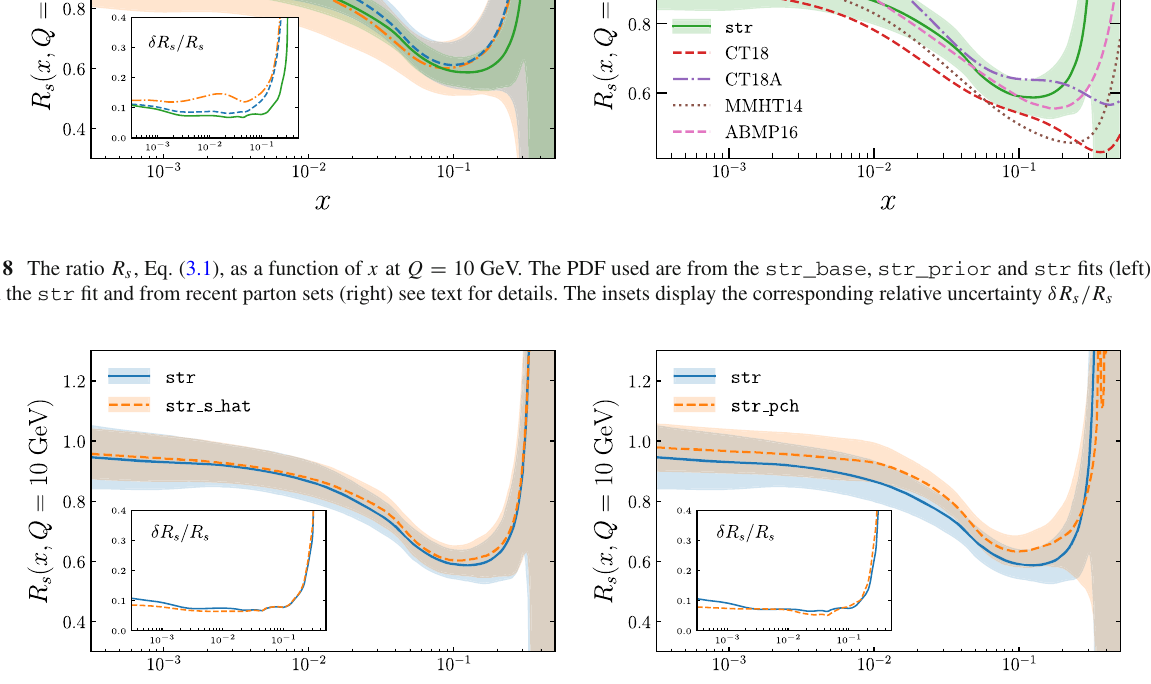
Fig. 9 Same as Fig. 8, comparing fits to the E ν -dependent ( str ) or to the fitted ( str ) or perturbative ( str_pch ) charm